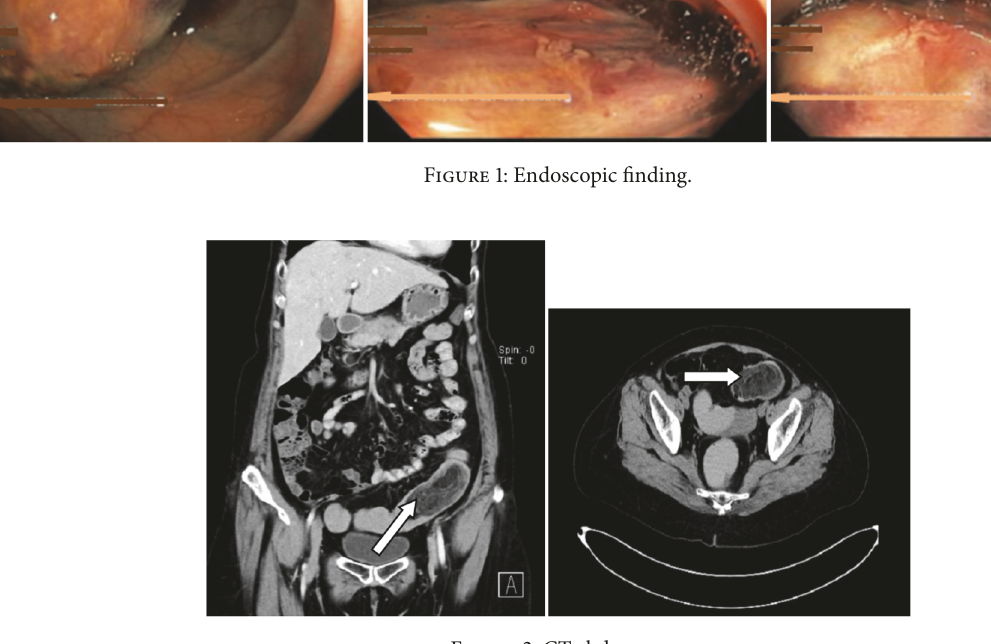
Figure 2: CT abdomen.